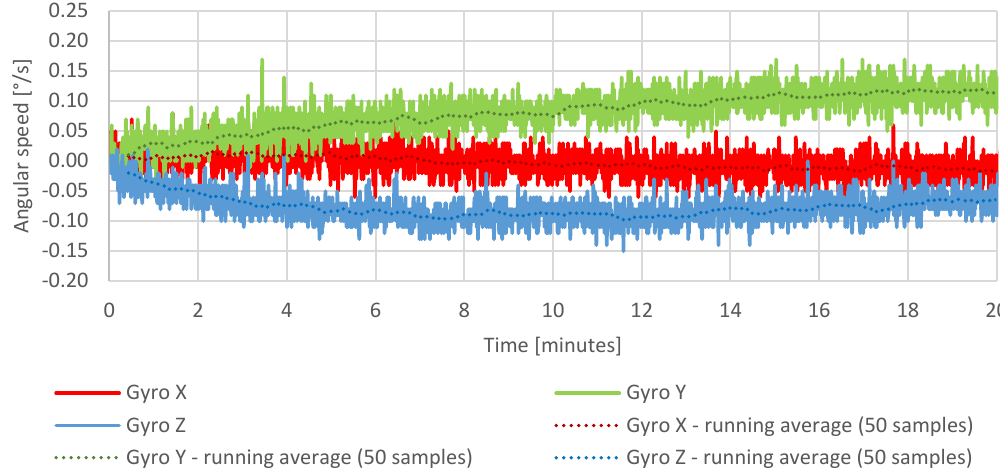
Figure 15. Sensor temperature during the test.